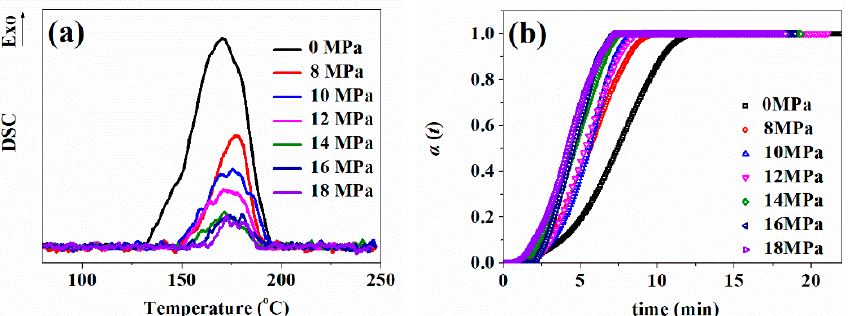
Figure 6. ( a ) Non-isothermal DSC curves; ( b ) Relationship between the relative conversion and the vulcanization time for pre-vulcanized silicone rubber samples after being saturated under different pressures.